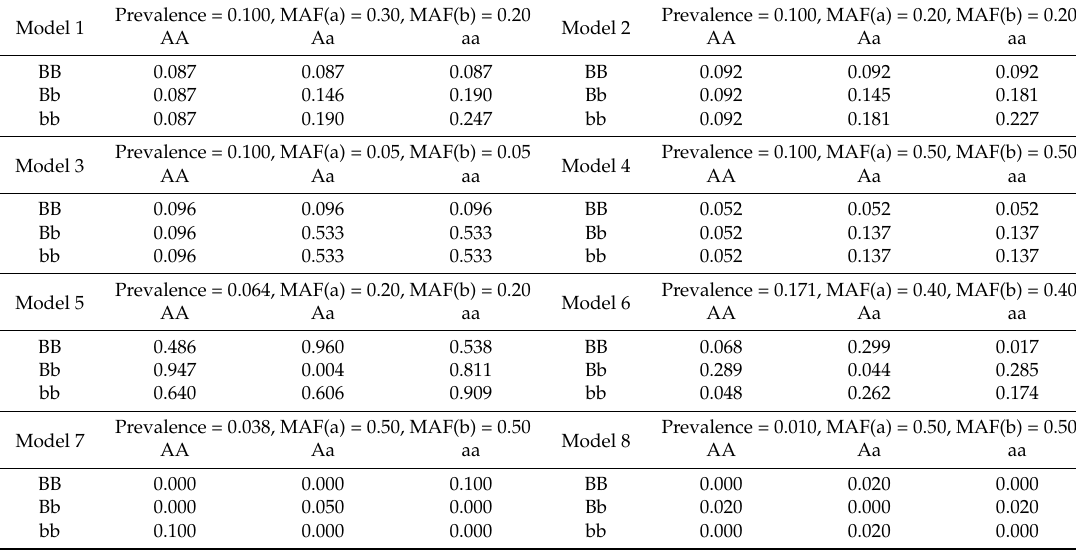
Table 1. Details of eight commonly used two-locus epistasis